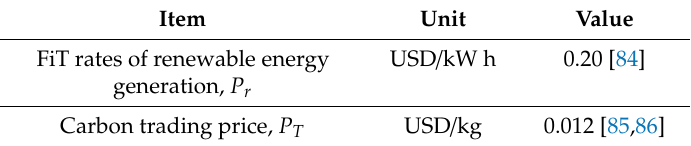
Table 12. Economic reference data for assessing the annual comprehensive benefit of the